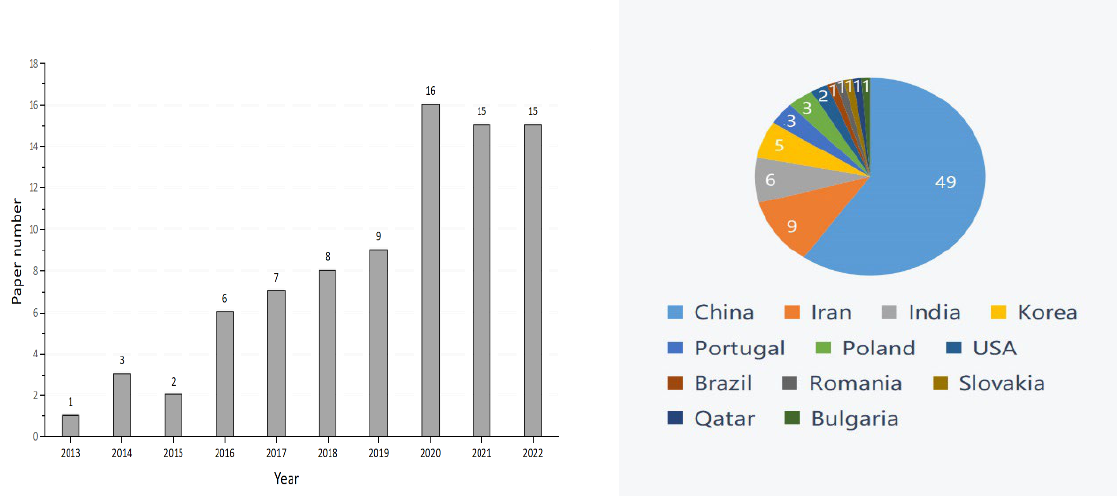
Figure 1. Number of publications on the effects of graphene oxide on plant growth (data from PubMed), search conducted in October, 2022.